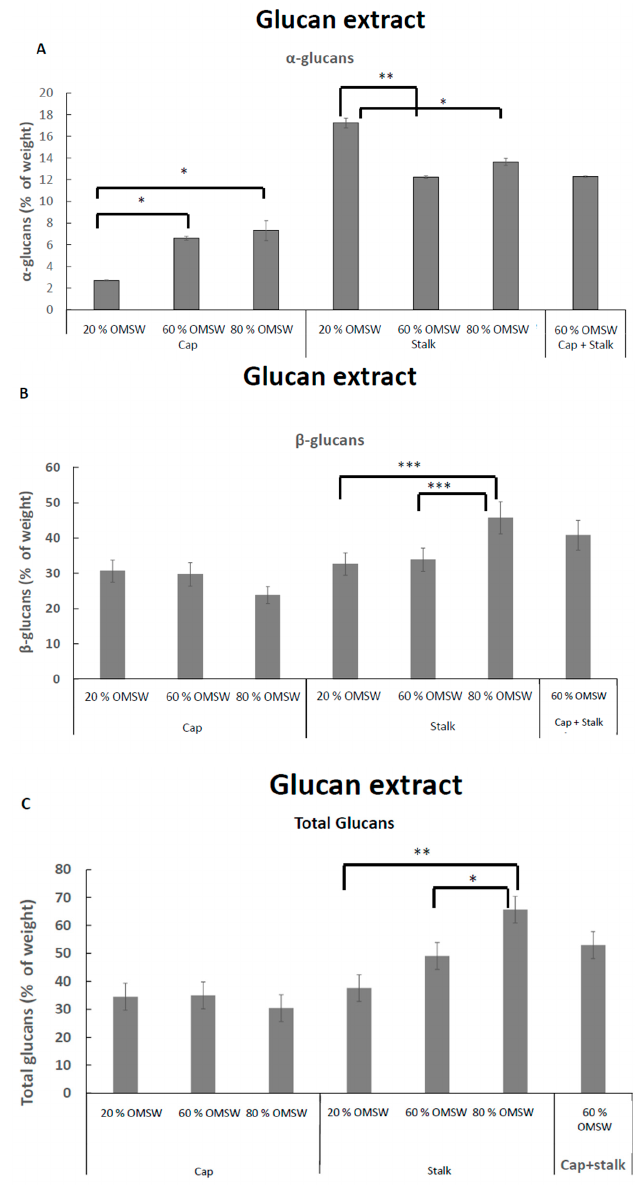
Figure 4. α ( A ), β ( B ), and total ( C ) glucan concentrations in glucan extracts prepared from caps